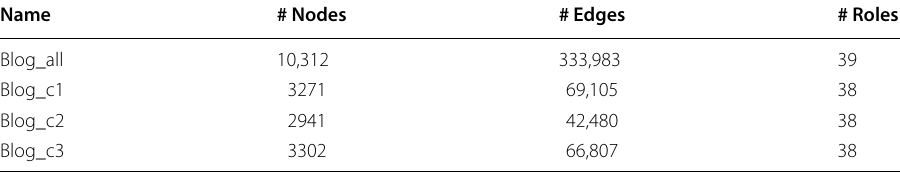
Table 3 Statistics of Blogcatalog network and communities